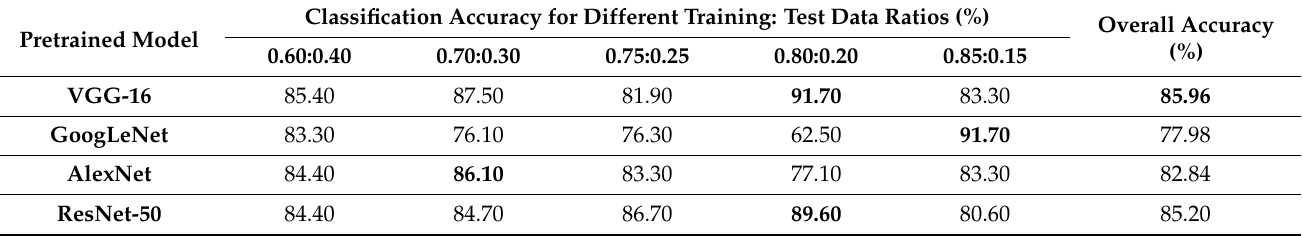
Table 3. Pretrained networks performance summary for different training: testing data split ratios. Classification Accuracy for Different Training: Test Data Ratios Pretrained Model